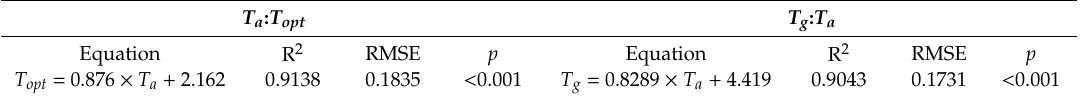
Table 2. Regression and correlation between variables T a , T g , T opt .